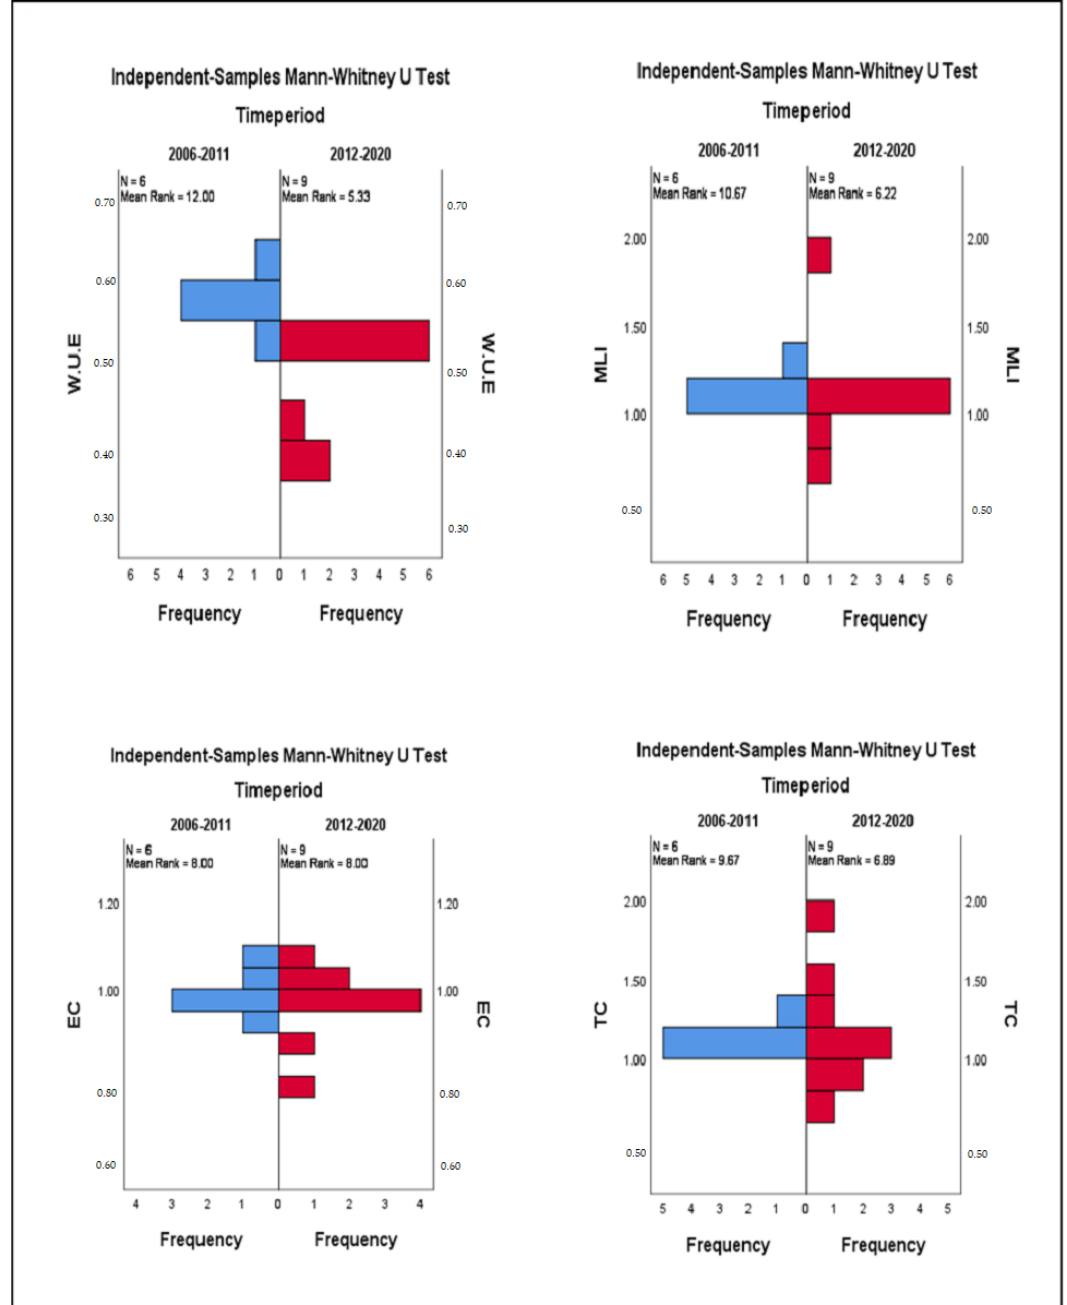
Figure 6. Distribution of average WUE, MLI, EC, and TC across different periods.